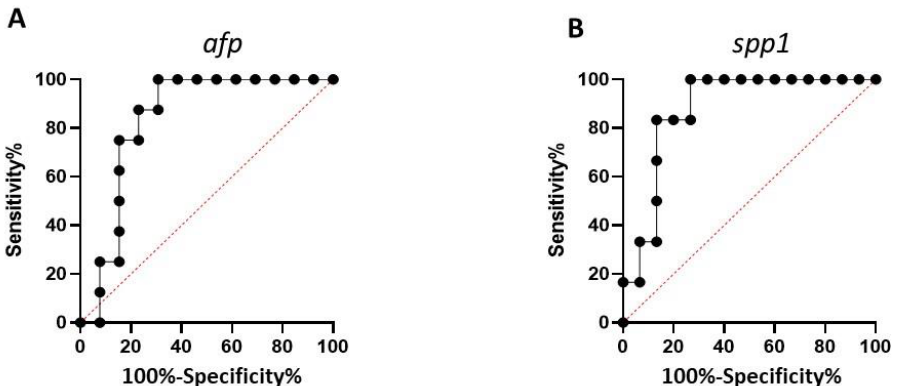
Figure 7. Hepatic onco- genes as diagnostics for HCC: ( A ) ROC for hepatic afp; and ( B ) spp1 as diagnostics for HCC in NASH.